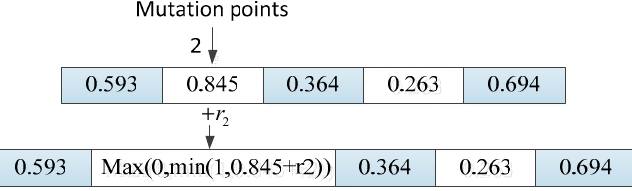
Figure 3. Gaussian mutation operation.